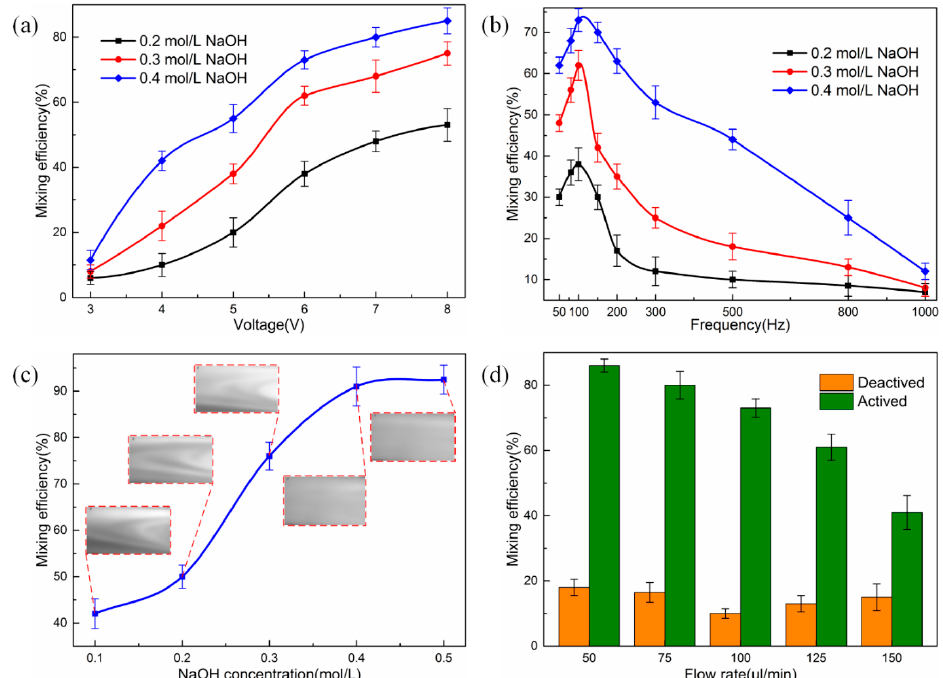
Figure 4. Mixing efficiency with respect to sinusoidal signals with different magnitudes and frequencies, NaOH solutions with different concentrations, as well as different inlet flow rates. ( a ) plot for the mixing efficiency vs. voltage magnitude of the signal in a 0.2 mol/L, 0.3 mol/L, and 0.4 mol/L NaOH solution when a 100 Hz signal is applied; ( b ) plot for the mixing efficiency under different frequencies in a 0.2 mol/L, 0.3 mol/L, and 0.4 mol/L NaOH solution when a 6 Vpp signal is applied; ( c ) plot for the mixing efficiency vs. NaOH concentration after applying the electric field of 9 Vpp at 100 Hz; ( d ) mixing efficiency vs. flow rate plot, obtained when a 100 Hz, 6 Vpp sinusoidal signal is applied and the concentration of NaOH is 0.4 mol/L.